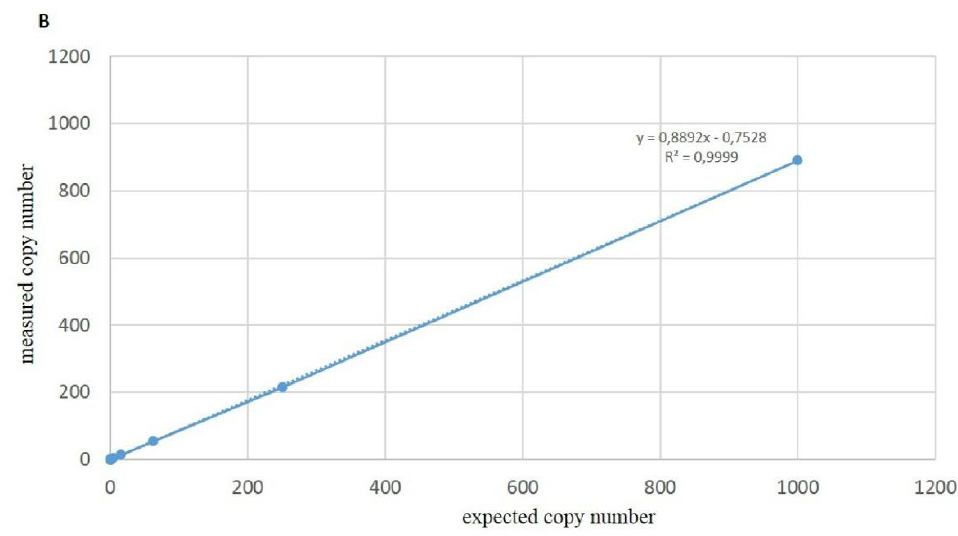
Figure 4. Linear correlation between values of measured copy number quantified by ddPCR ( y -axis) and the known copy number composition of samples obtained by the mixture of gDNAs from A.1 and B.1 monoconidial isolates ( x -axis). ( A ) Quantification of allele A143 in samples of group 1. ( B ) Quantification of allele G143 in DNA mixture of group 2.